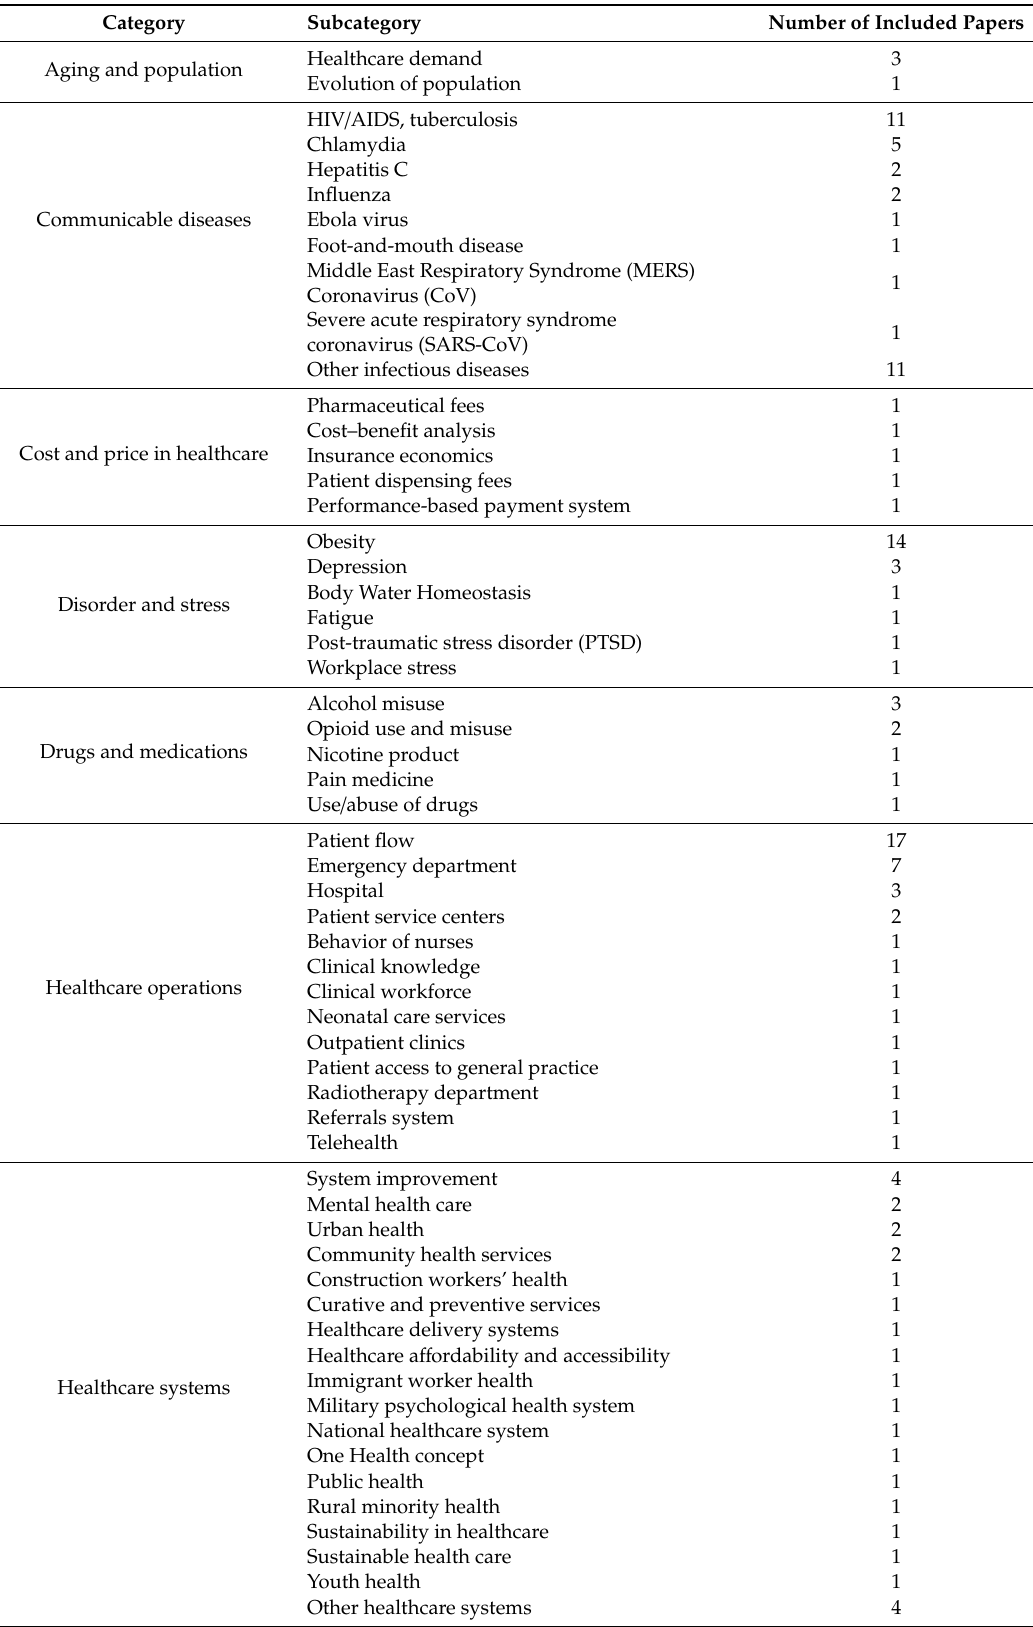
Table 4. Classification of the papers included in the present